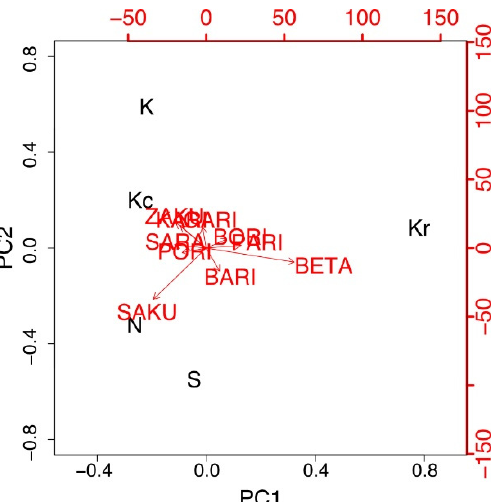
Figure 3. PCA biplots of the cumulative dominance duration of each mimetic word in Experiment 1. The variance in PC1 and PC2 contributed to 52% and 32%, respectively. Samples S, K, and N are available commercially and produced by different manufactures. Sample Kr was a moisturized and re-dried version of K, and Kc was a crushed version of K. PCA, principal component analysis. Figure 4a shows the time-course of changes in liking scores for all the samples. A one-way repeated measures ANOVA was performed for the average liking scores averaged over time and indicated a significant main effect of the food sample [ F (4, 76) = 31.84, p < 0.05, η p2 = 0.63] (Figure 4b). A post-hoc multiple comparison test revealed that the liking score for Kr was significantly lower than that for the remaining four samples ( p s < 0.05 with Ryan’s test) and that the liking score for N was significantly lower than that for S ( p <